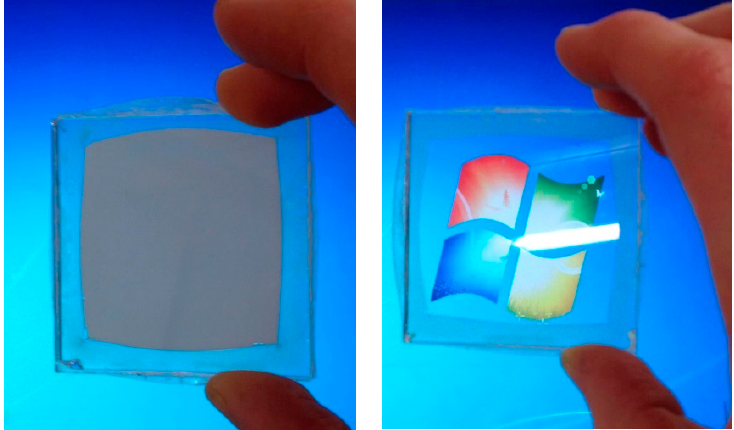
Figure 10. Measured transmittance and reflectance data for aqueous 6 wt. % HPC at 600 nm, Vis